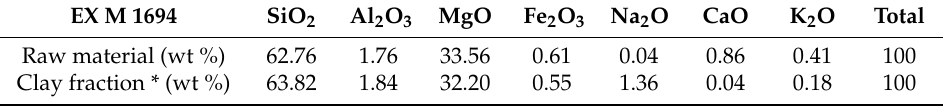
Table 1. Chemical composition of raw material and clay fraction (normalized to ignited conditions).